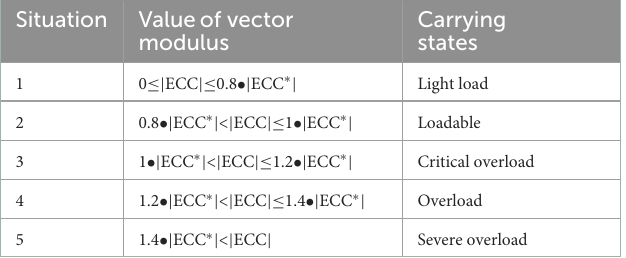
TABLE 2 Value of vector modulus of coastal ecosystem carrying capacity and carrying status.